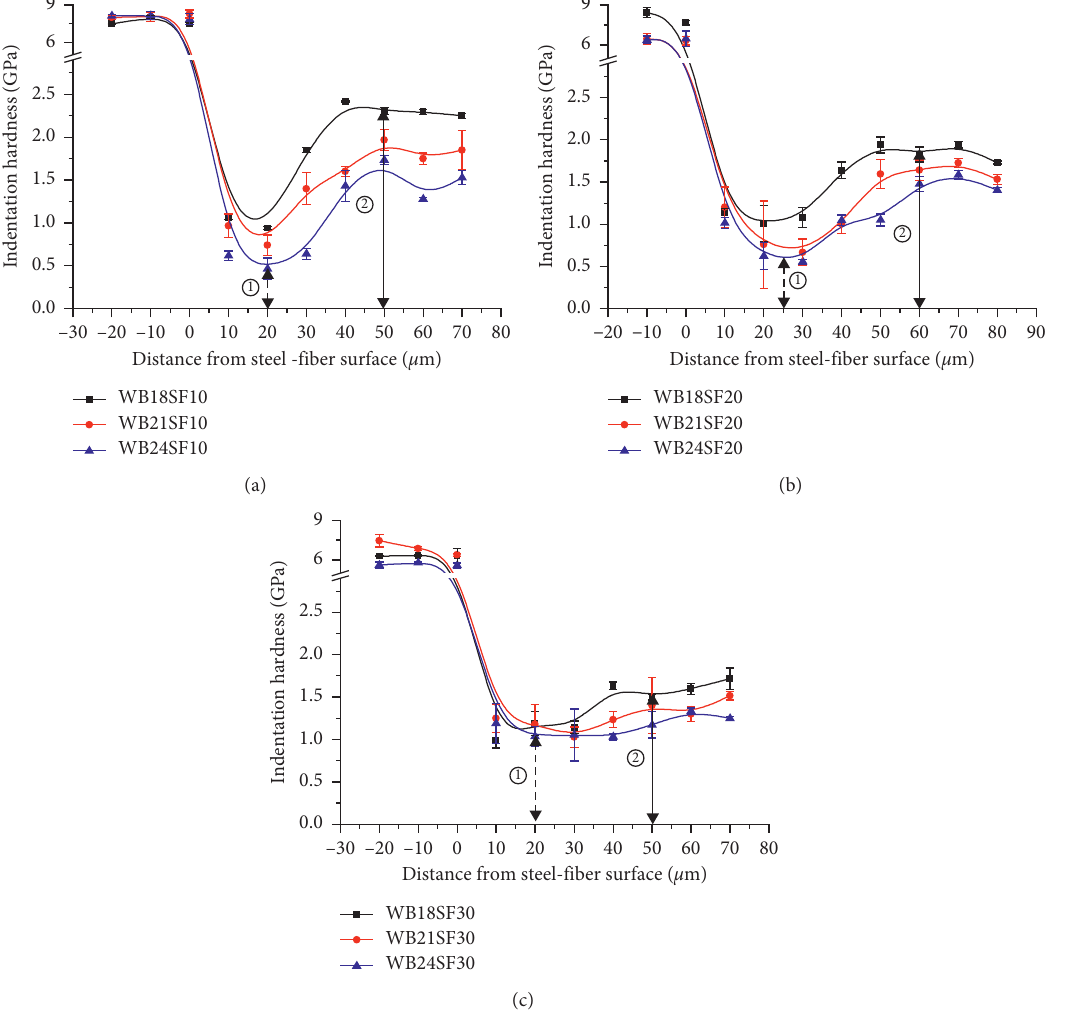
Figure 7: Indentation hardness with distance from the steel-fiber surface for different silica fume contents. (a) Silica fume content of 10%. (b) Silica fume content of 20%. (c) Silica fume content of